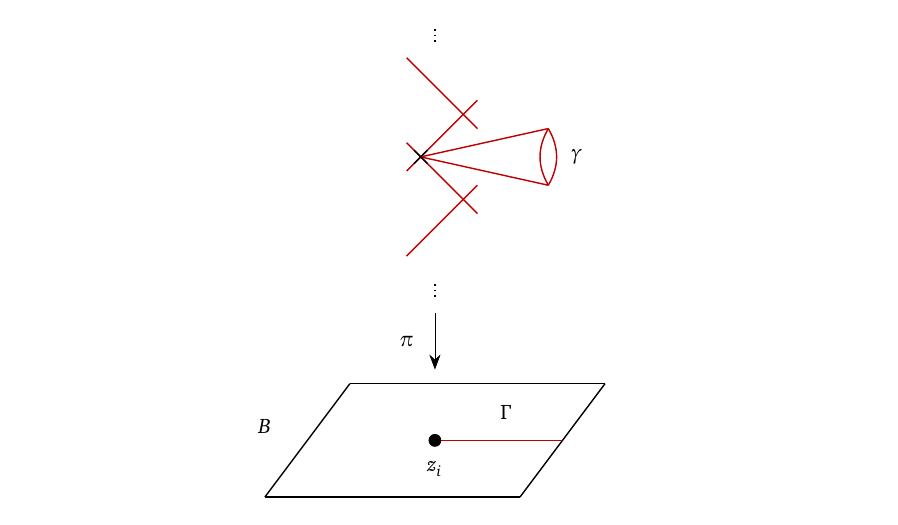
Figure 2: Picture of a representative for the thimble T to the path Γ ⊂ B terminating at z algebraic geometry with each straight line denoting a rational curve introduced by the